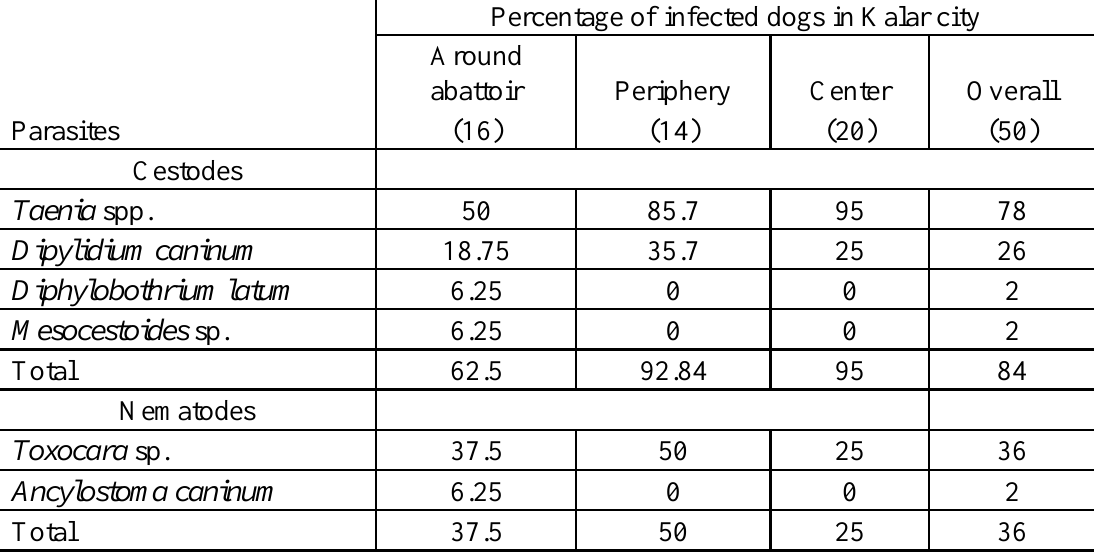
Table 2 Percentage of dogs infected with different helminths in various regions of Kalar city (number in parentheses indicates number of dogs